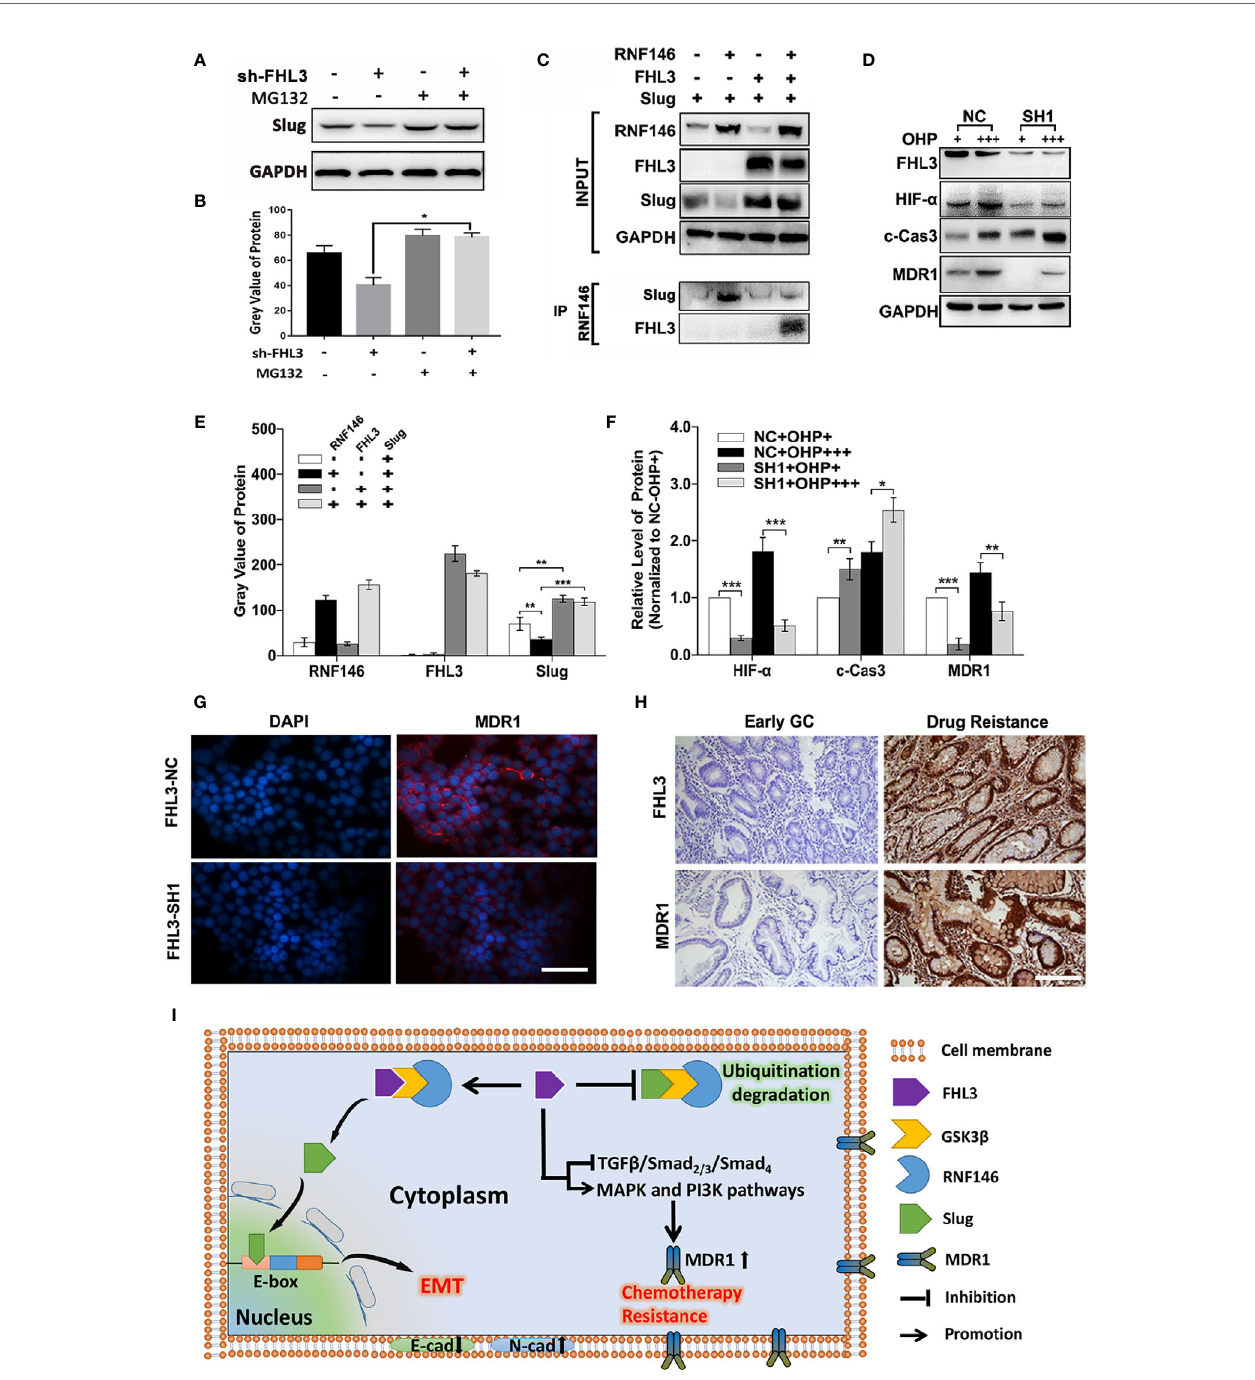
FIGURE 8 | The molecular mechanisms of FHL3-mediated EMT and chemotherapy resistance. (1) Ubiquitin inhibitor bortezomib was added into the medium of FHL3-NC and SH1 to observe the regulation of Slug; it might reverse the FHL3-downregulation-induced decrease of Slug (A, B) ; (2) 293T cell was transfected with Slug-plasmid and/ or RNF146-plasmid and FHL3-plasmid, and the basic expression of those protein was detected by western blot (C, E) ; Co-IP assay was used to detect the interaction between FHL3, Slug, and RNF146, and the result suggested that RNF146-myc can interact with FHL3-HA and Slug-Flag (C) ; (3) The levels of HIF-1 a , cleaved-caspase-3 and MDR1 were investigated in OHP-resistance FHL3-NC/SH1cells (D, F) ; (4) The relationship of FHL3 and MDR1was investigated in GC cell line and slices; IHC showed that advanced GC with chemotherapy resistance has higher level of FHL3 and MDR1 (200× magni fi cation) (G, H) . (5) Mechanism scheme: FHL3 leads to EMT via competitively bonding the ubiquitin complex with Slug, and multi-pathway activation contributes to chemotherapy resistance (I)